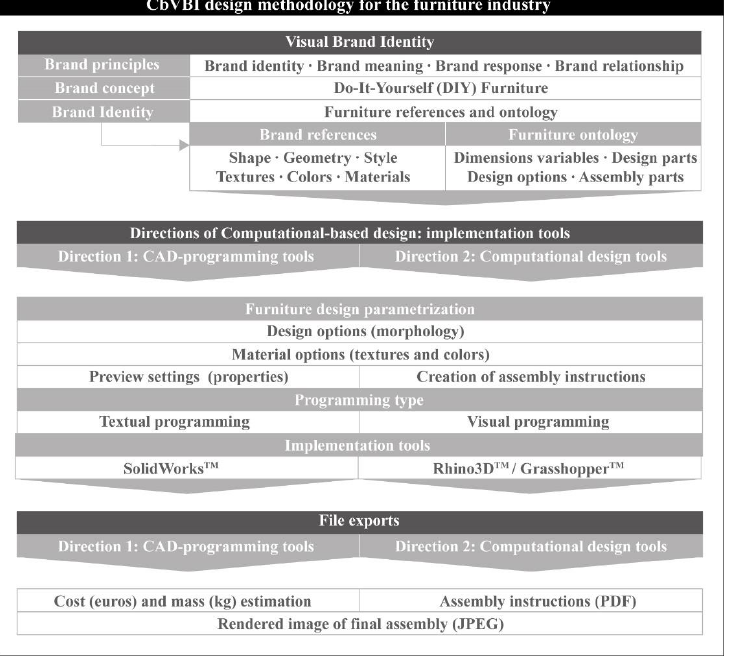
Figure 1. Computational-based Visual Brand Identity design methodology for the furniture indus- try.